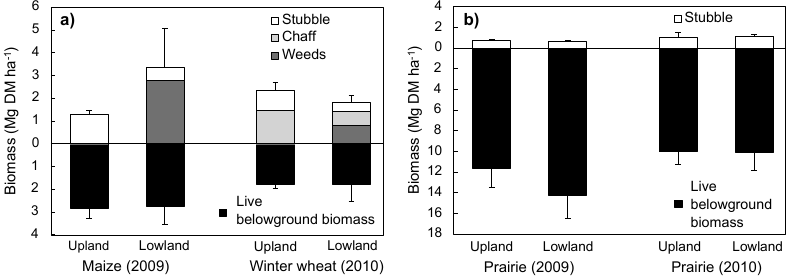
Figure 4. Upland and lowland unharvested biomass and belowground live biomass in ( a ) row crops; ( b ) prairie. Error bars depict the standard error of total above and belowground biomass. Note the differences in scale between panels.